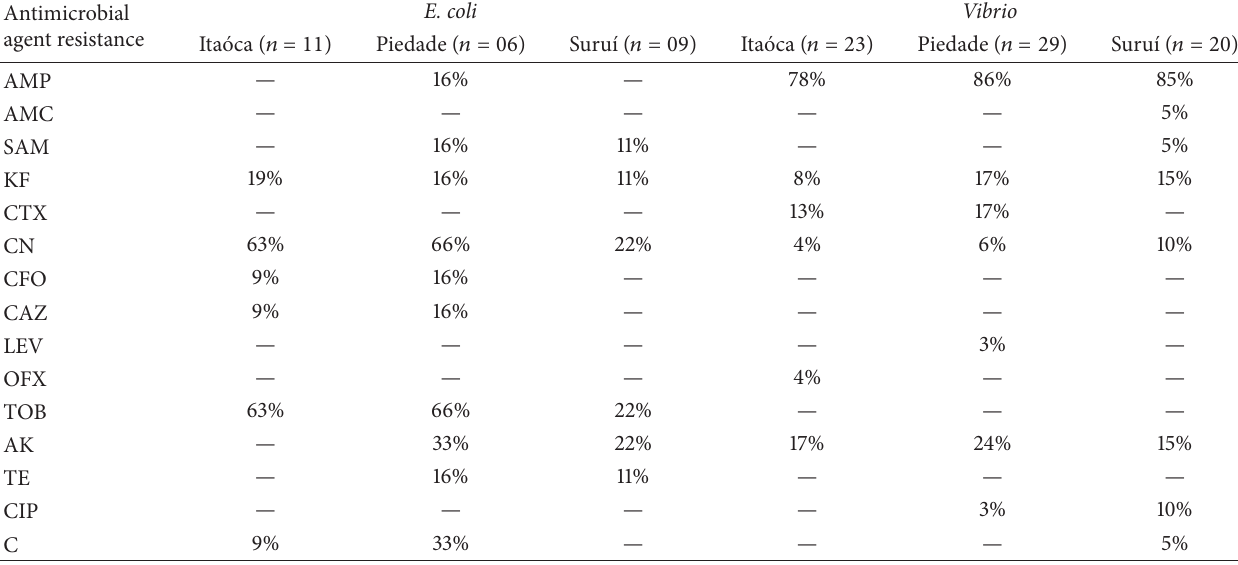
𝑛 : number of tested strains. AMP: ampicillin; AMC: amoxicillin + clavulanic acid; SAM: ampicillin/sulbactam; KF: cephalothin; CTX: cefotaxime; CFO: cefoxitin; CAZ: ceftazidime; LEV: levofloxacin; CIP: ciprofloxacin; OFX: ofloxacin; CN: gentamicin; TOB: tobramycin; AK: amikacin; TE: tetracycline; C: